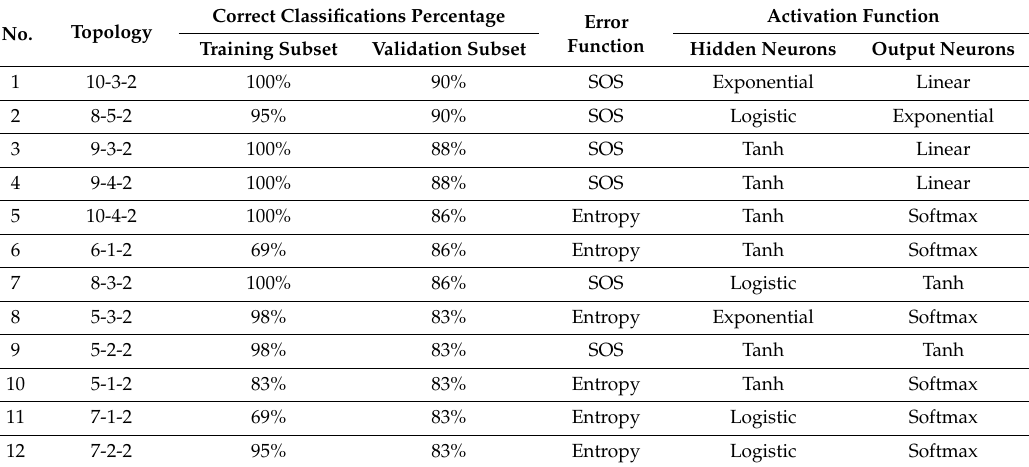
Table 3. Multilayer perceptrons designed for the detection of H. pylori infection.